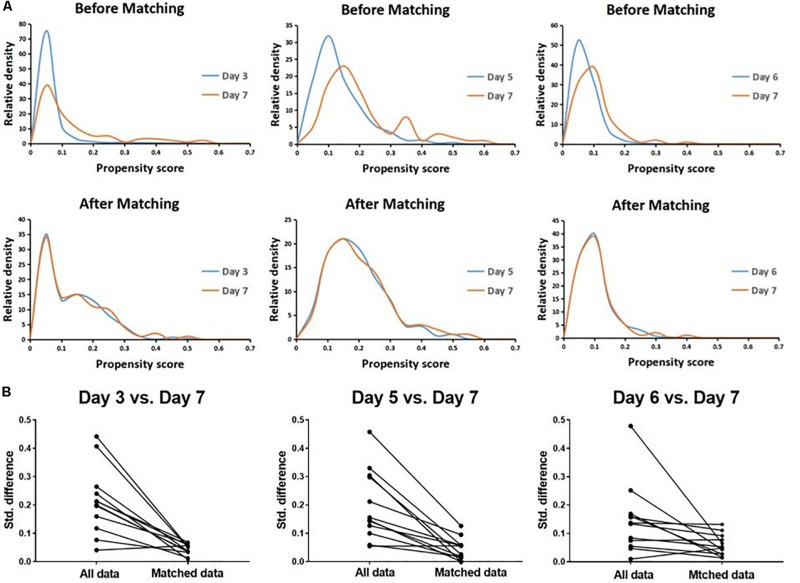
Propensity score matching (PSM) for day 3 vs. day 7, day 5 vs. day 7, and day 6 vs. day 7 cohorts, respectively. The relative density of propensity scores (A) and standard differences (B) before and after PSM showed balance between the compared cohorts.